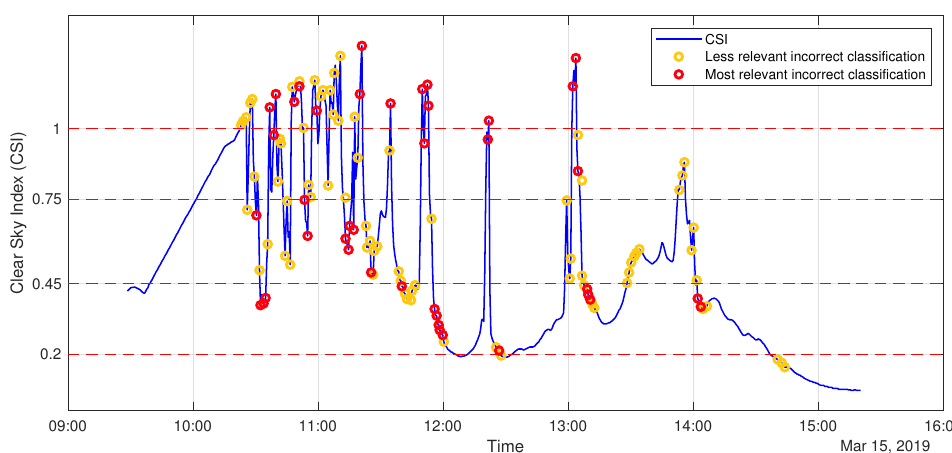
Figure 12. CSI trend with highlighted classification errors for the day of 15 March 2020.